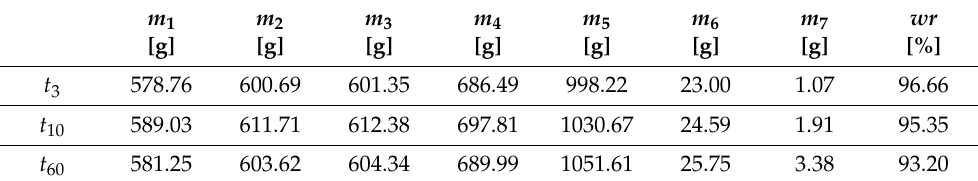
Table 4. Results of the water retention test performed on one unreinforced mortar specimen.